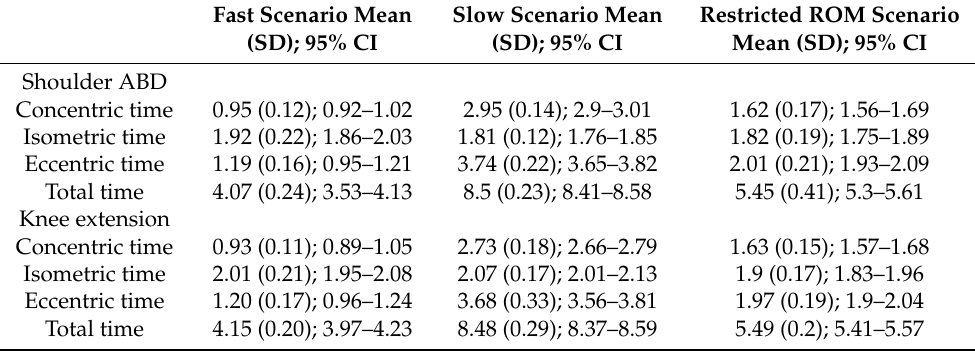
Table 1. TUT parameters (in seconds) by scenario and phase for shoulder abduction and knee